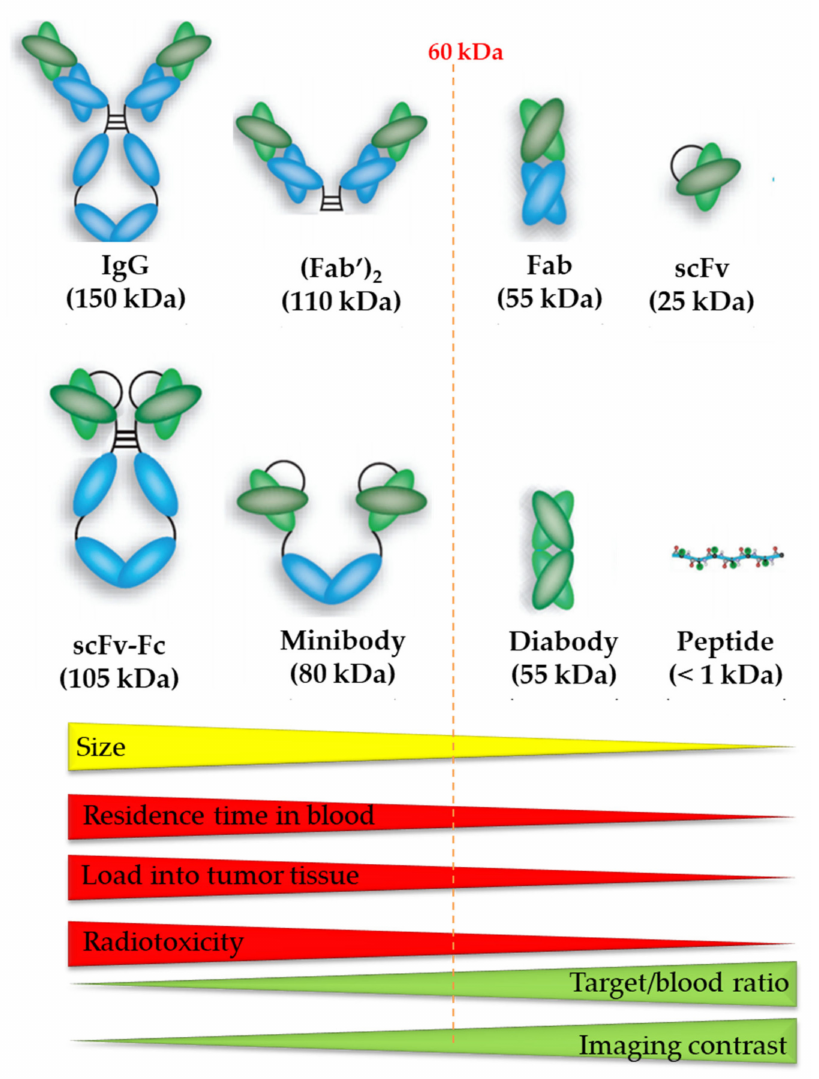
Figure 6. The size of the vector molecule determines the residence time of blood, tumor accumulation, radiotoxicity, target-to-blood ratio, and imaging contrast of the radiopharmaceutical. Image was adapted from Hong H. et al., 2008 and modified with permission from [79], SAGE Journals,